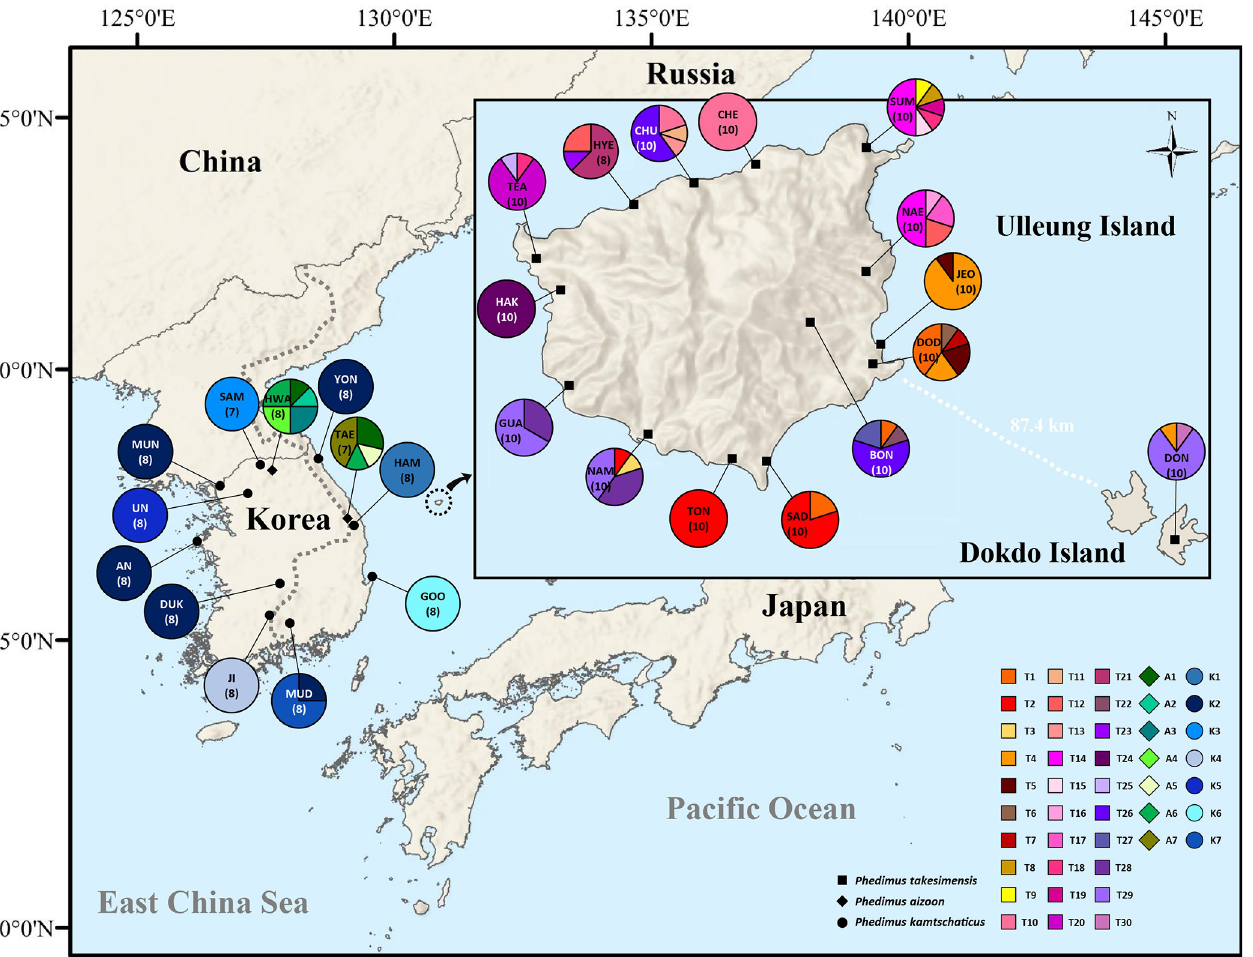
Fig 2. Map of the haplotypes found in insular derived Phedimus takesimensis and two continental progenitor species, P . kamtschaticus and P . aizoon . Different colored portions in each pie chart represent the haplotype frequencies.